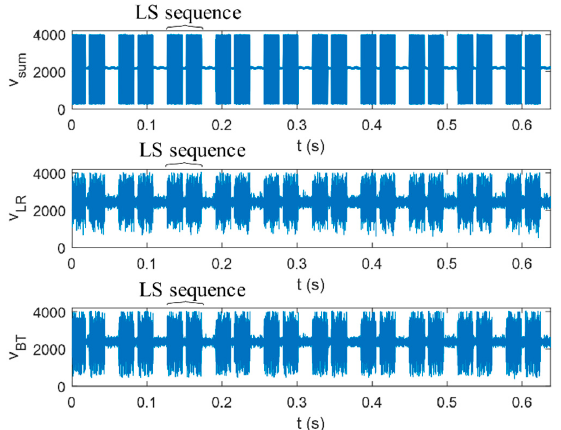
fsum , v fLR , v fBT